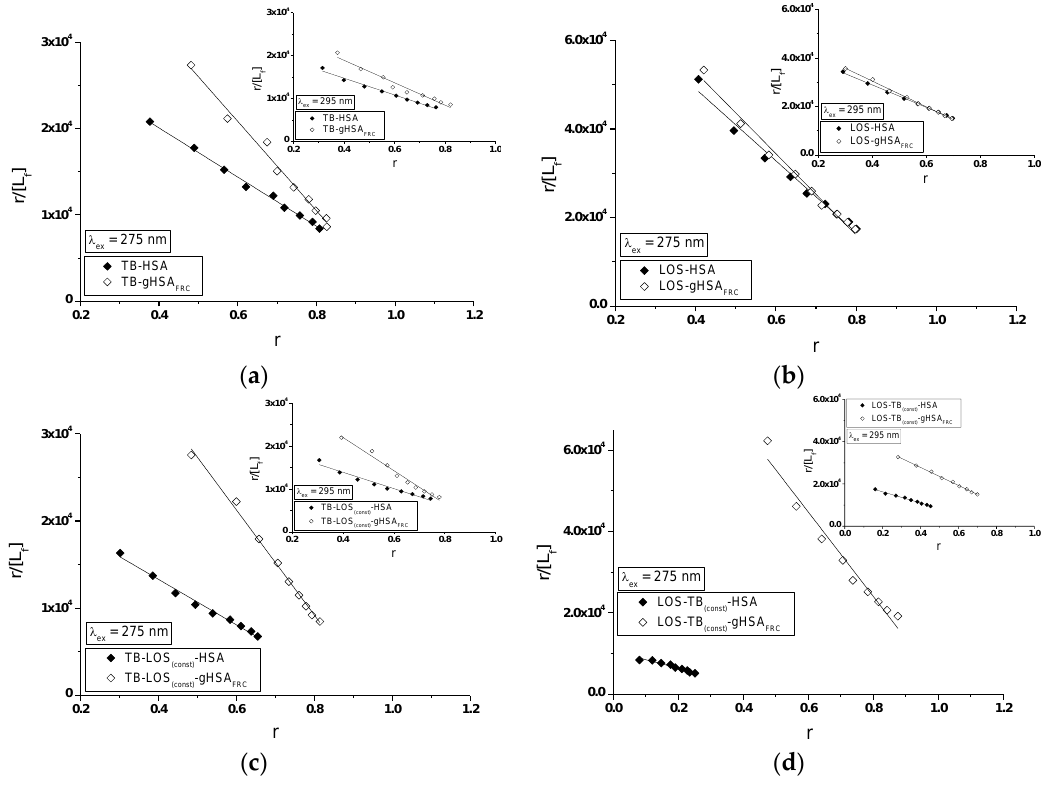
Figure 16. Scatchard curves of 𝑟 vs. 𝑟 for the binary systems ( a ) TB-HSA, TB-gHSA FRC , ( b ) LOS-HSA, LOS-gHSA FRC and ternary systems ( c ) TB-LOS (const) -HSA, TB-LOS (const) -gHSA FRC , ( d ) LOS-TB (const) -HSA, LOS-TB (const) -gHSA FRC ; λ ex = 275 nm (main view) and λ ex = 295 nm (insert); the error bars are smaller than the symbols.